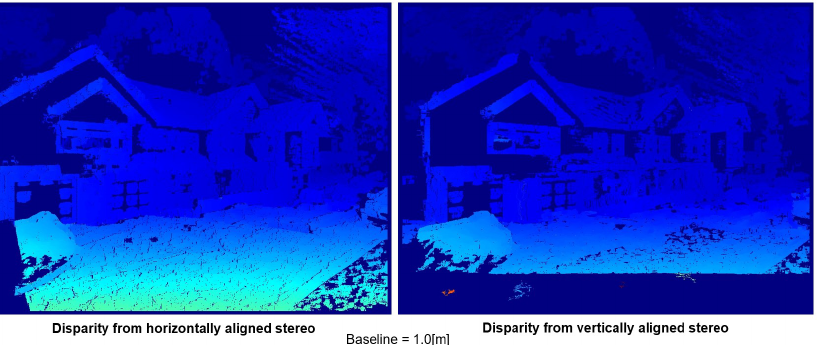
Figure 11. Comparison of locally normalized disparity images from horizontal stereo configuration ( left ) with vertical stereo configuration ( right ).